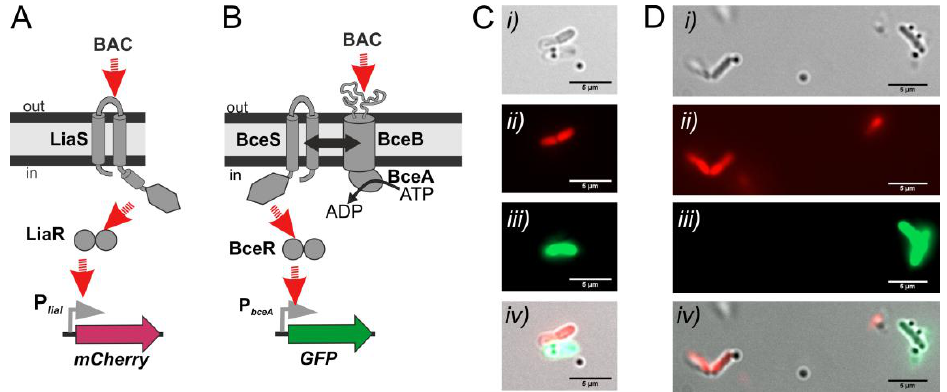
( ii ) green fluorescence, ( iii ) merged images. Scale bar is 5 µ m.